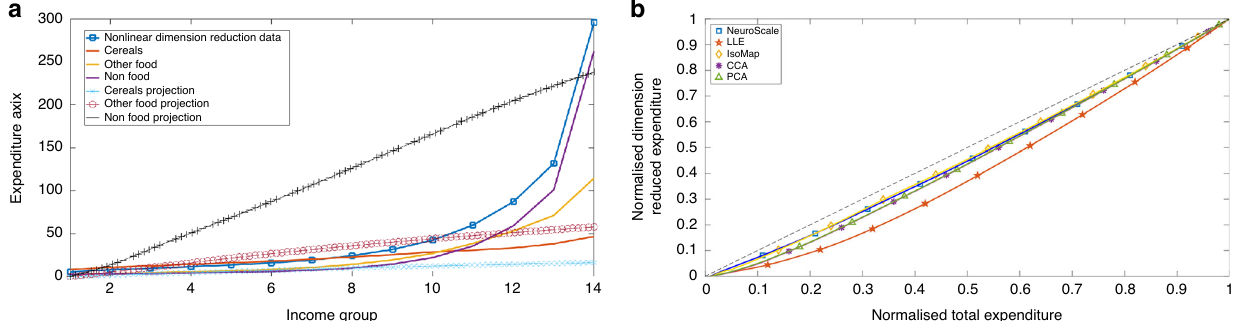
Fig. 4 Expenditure versus Income - Individual Expense Category against Multivariate Distribution. Expenditure versus income plots ( a ) and machine learned multivariate projections ( b ). The y -axis variables are ( y , z NS ), ( y , z lle ),.. and ( y , z PCA ), where z NS is the NeuroScale projection of the data to the univariate model etc., and z PCA = w 1 × C 1 + w 2 × C 2 + w 3 × C 3, where machine learned eigenvalues.